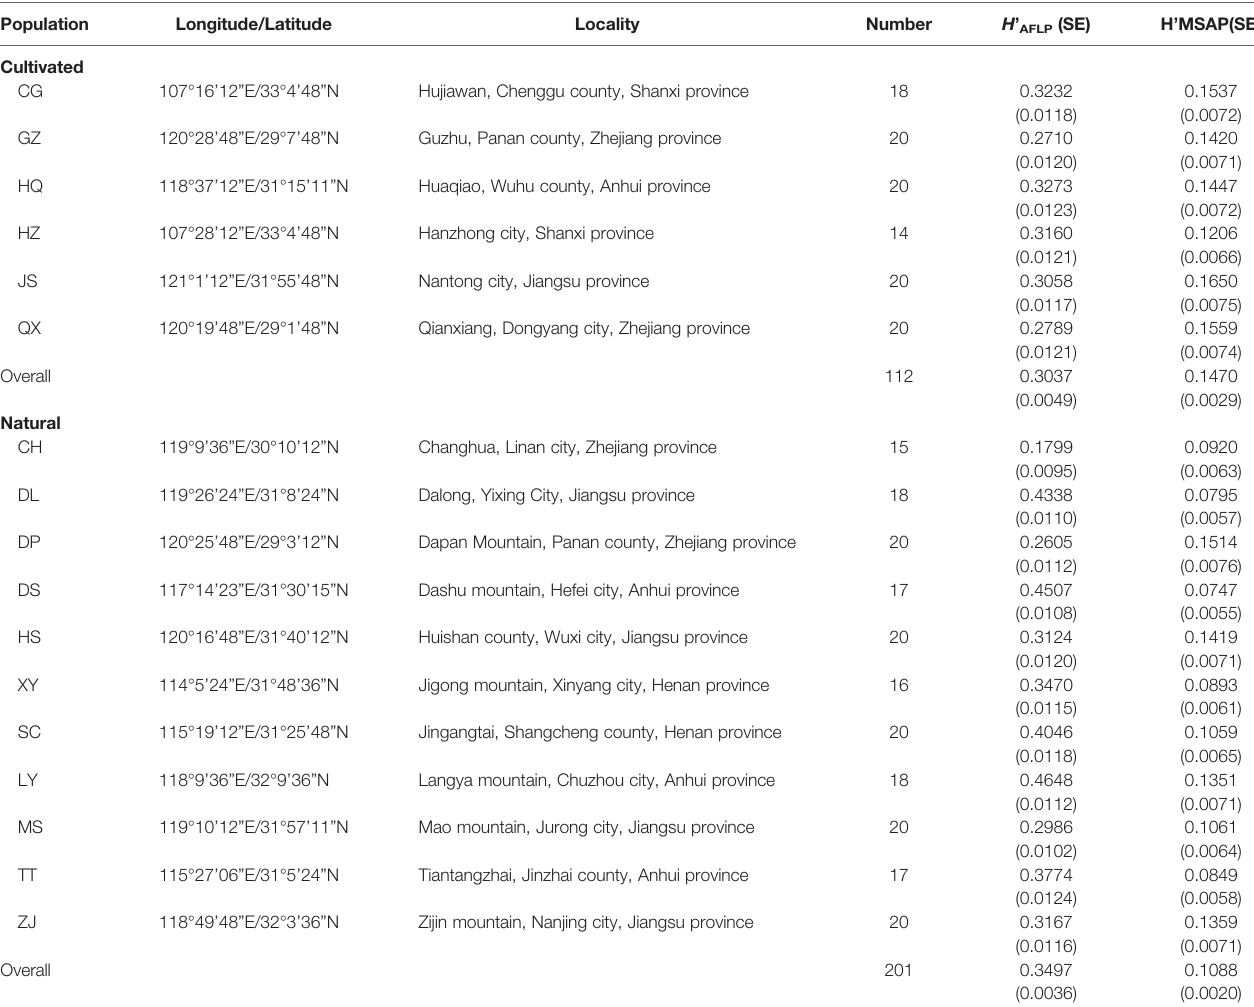
TABLE 1 | The epigenetic and genetic diversity index across the 17 populations of Corydalis yanhusuo .